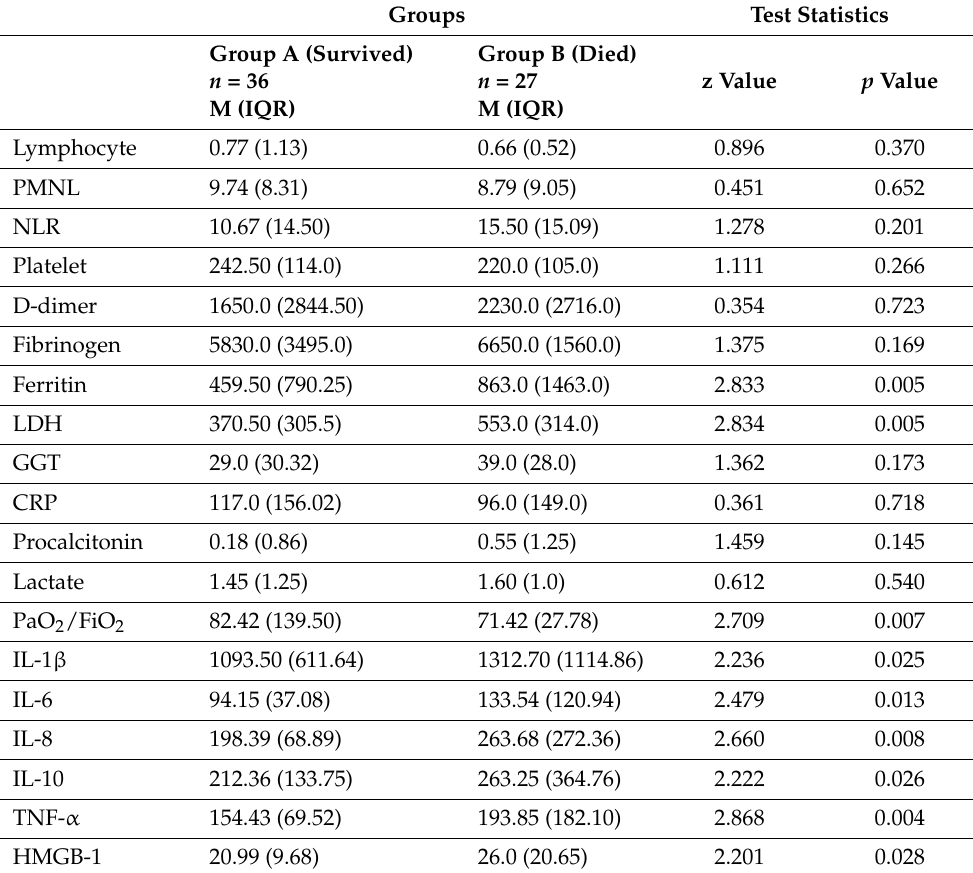
Table 2. Comparison of blood count, biochemical parameters, and cytokine levels among the groups. Groups Test Statistics